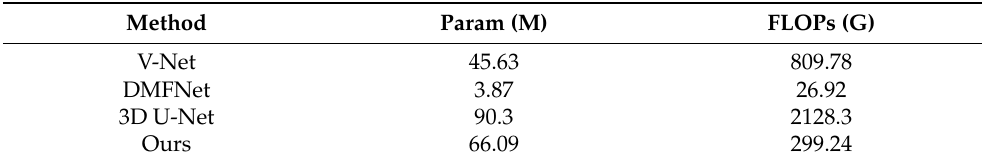
Table 2. Shows the comparison of Param, FLOPs of different methods (V-Net, DMFNet, 3DU-Net and Ours).